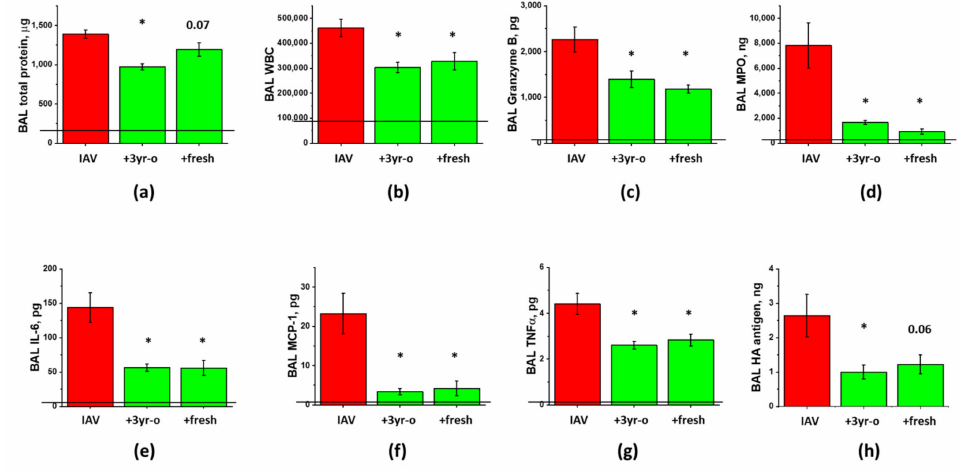
Figure 5. Long-term storage at − 80 ◦ C does not compromise ASC-CS ability to limit lung injury in IAV-infected mice. Female C57Bl/6 mice received intranasal administration of IAV H1N1 PR8 (800 pfu/mouse) on Day0. On Day6 and 8, IAV mice were sub-cutaneously injected with 2.25 mg/kg of fresh or 3 year-old (3y-o) ASC-CS (green columns) or an equivalent volume of PBS (red columns). BAL fluids were collected on Day9 to analyze for total protein levels ( a ), white blood cell counts ( b ), granzyme B ( c ) and myeloperoxidase levels ( d ), IL-6 ( e ), MCP-1 ( f ) and TNFa levels ( g ), and PR8 hemaggutinin (HA) levels ( h ). n = 4–5 per group, presented are mean +/ − SEM. Lines indicate levels of analytes detected in control (saline to lung) mice. * for p < 0.05 by t -test with Welch correction (unequal variances) between CS groups and IAV